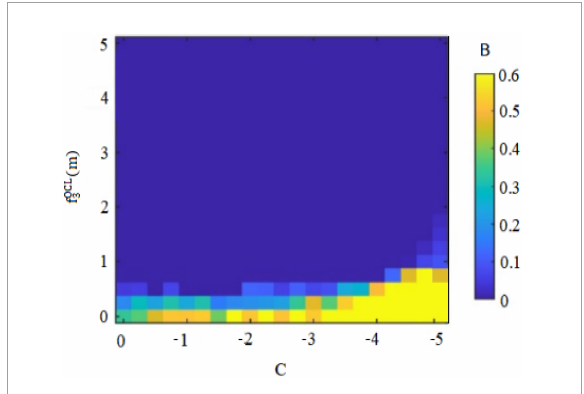
FIGURE10 Psychological capital, perceived benefits and deviant innovative behavior (low internal control